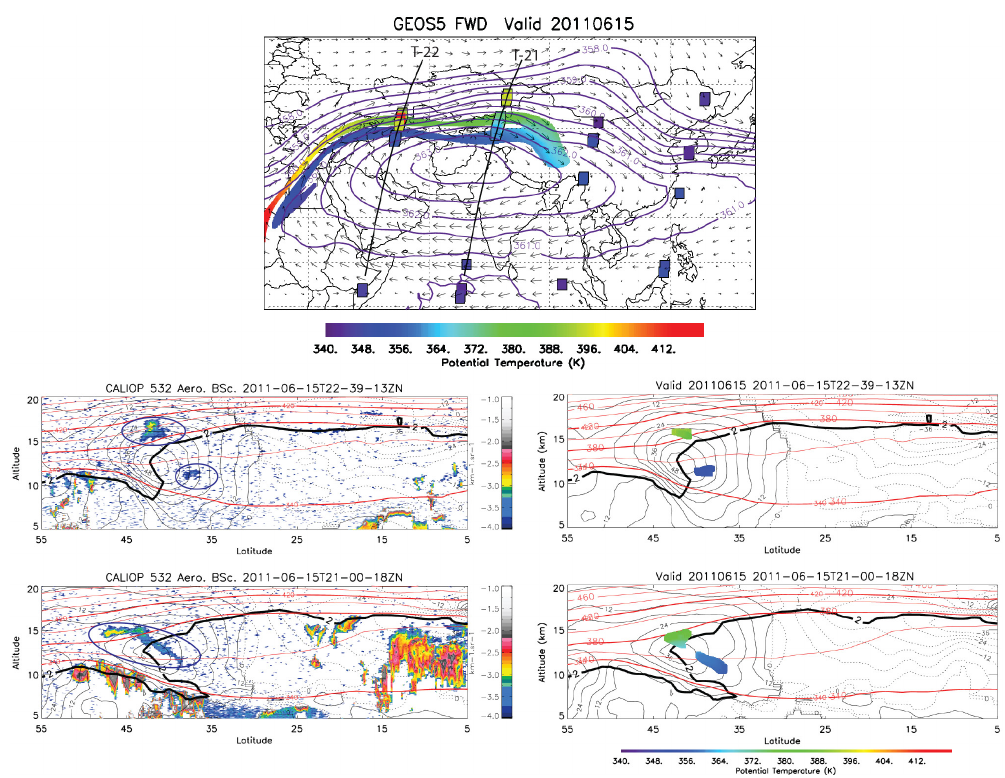
Figure 3. Top: map of air parcel locations from 18:00Z to midnight on 15 June, from the trajectory source simulation (colored by initial θ ), and cloud-cleared level-2 CALIPSO aerosol tops (squares, colored by θ ). Contours of MSF (purple) and wind vectors at 380K are also shown. Left: 532 nm attenuated aerosol backscatter curtains. Right: coincident trajectory curtains for the CALIPSO nighttime orbits crossing the plumes T22-39-13ZN and T21-00-18ZN , and marked by black curves on the map (top). Trajectories within 5 ◦ of longitude are projected on to the cross sections. Nabro aerosol layers are highlighted by ovals. Isopleths of wind speed (signed by zonal wind component) (thin, black), θ (red), and PV = 2.0 PVU (bold, black) are also